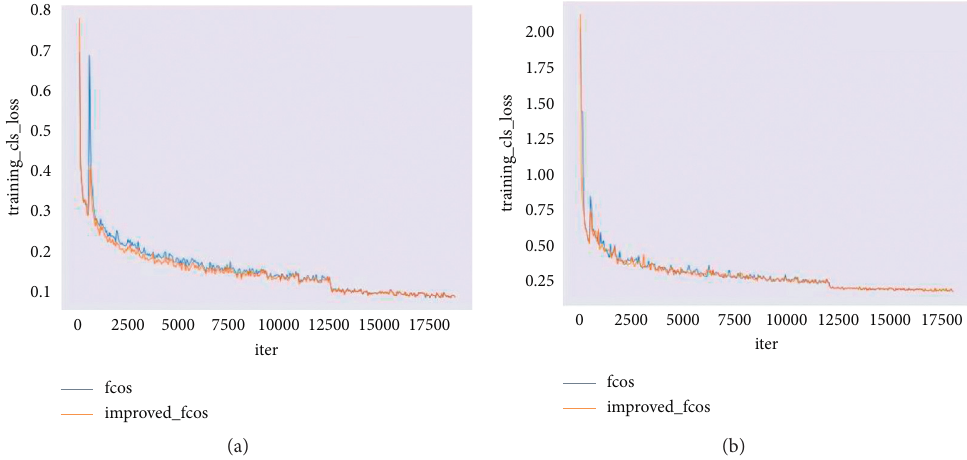
Figure 8: The linechart of cls and bbox loss, where the earlier loss_cls converges faster and the fluctuation is minor.